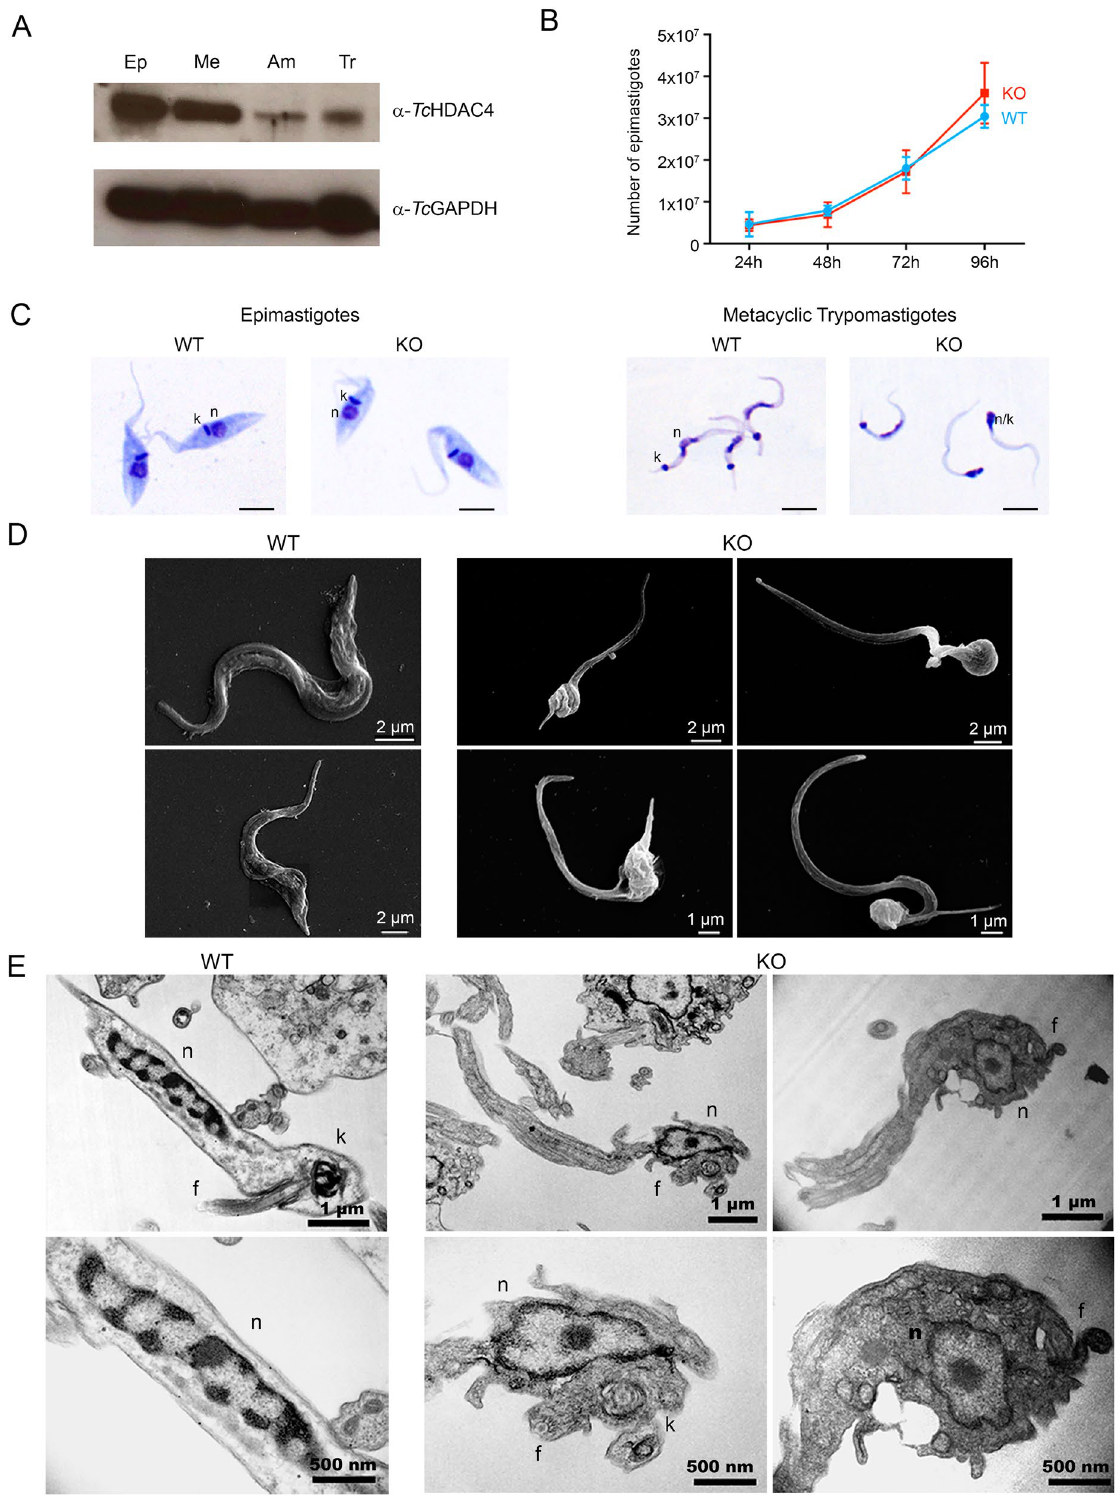
Figure 1. Tc HDAC4 is expressed throughout the T. cruzi life cycle with higher levels present in the insect-equivalent stages of the life cycle reproduced in vitro and its knockout affects cell morphology during metacyclogenesis. ( A ) Immunoblot using anti- Tc HDAC4 serum in cell extracts from epimastigote (Ep), metacyclic trypomastigote (Me), amastigote (Am) and cell culture-derived trypomastigote (Tr) cells. α- Tc GAPDH was used as a loading control. Only the part of the immunoblot corresponding to position of the Tc HDAC4 and Tc GAPDH bands is shown. Complete image of the western blot is presented in Supplementary Figure CI-1. ( B ) Proliferation curves obtained from biological triplicates. ( C ) Panoptic staining of epimastigote and metacyclic trypomastigote cells from wild type (WT) and Tc HDAC4 null mutant (KO) cells. Scale bars = 5 µm. ( D ) Scanning electron microscopy of metacyclic trypomastigote from wild type (WT) and Tc HDAC4 null mutant (KO) cells. ( E ) Transmission electron microscopy of metacyclic trypomastigotes from wild type (WT) and Tc HDAC4 null mutant (KO) cells. The lower panels correspond to larger magnification of the nuclear region of the same cells shown in the upper panel. n: nucleus, k: kinetoplast, f: